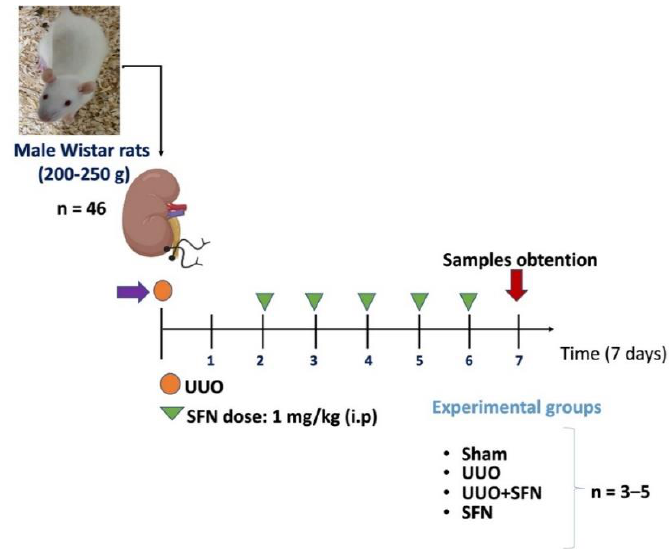
Figure 1. Experimental design. A total of 46 male Wistar rats were divided into four groups: (1) Sham group, in which surgery was simulated without ligation of the ureter, (2) unilateral ureteral obstruction (UUO) group, with double-ligating the left ureter for seven days; (3) UUO group treated with sulforaphane (SFN) at a dose of 1 mg/kg intraperitoneally (i.p) (UUO + SFN); and (4) SFN group, which did not have surgery manipulation but was treated with SFN. The number for each experiment was 3–5 per group ( n = 3–5). The number of animals used for each experiment is specified in the figure legends for each experimental assay.